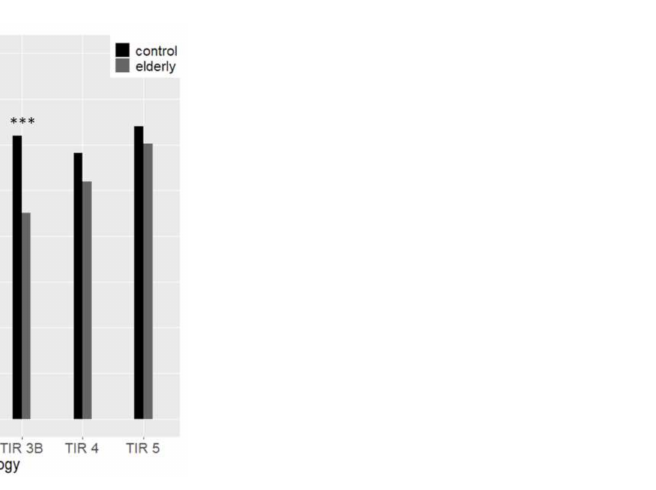
Figure 2. Surgical rate according to cytological categories. In grey are elderly patients; in black are the control group. * p < 0.05 *** p < 0.001.